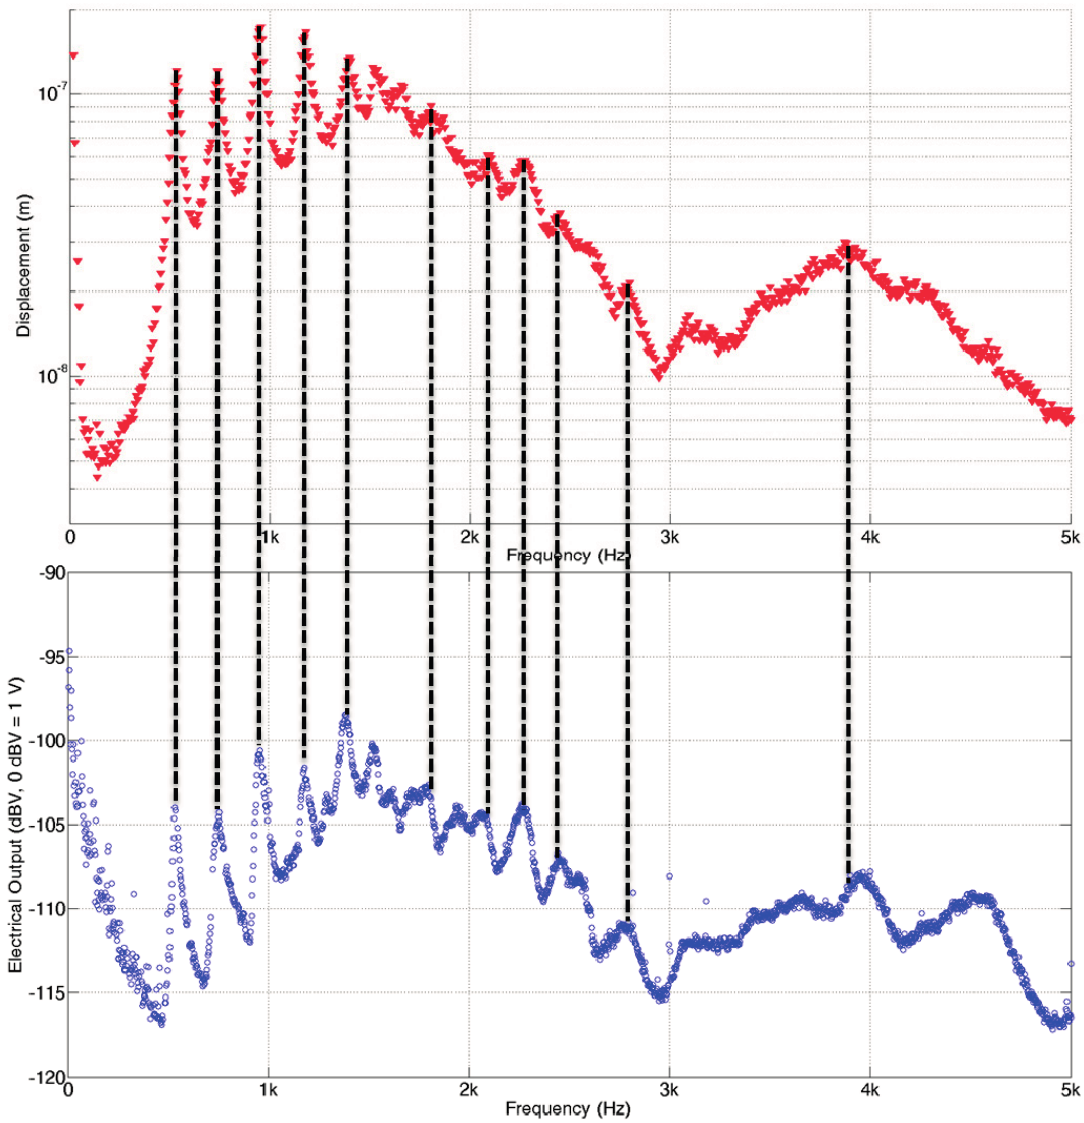
Figure 14. Vibratory and electrical characteristics of the packaged PAC: top graph represents the maximum displacement on the membrane and bottom graph represents the maximum electrical output from 13 electrical